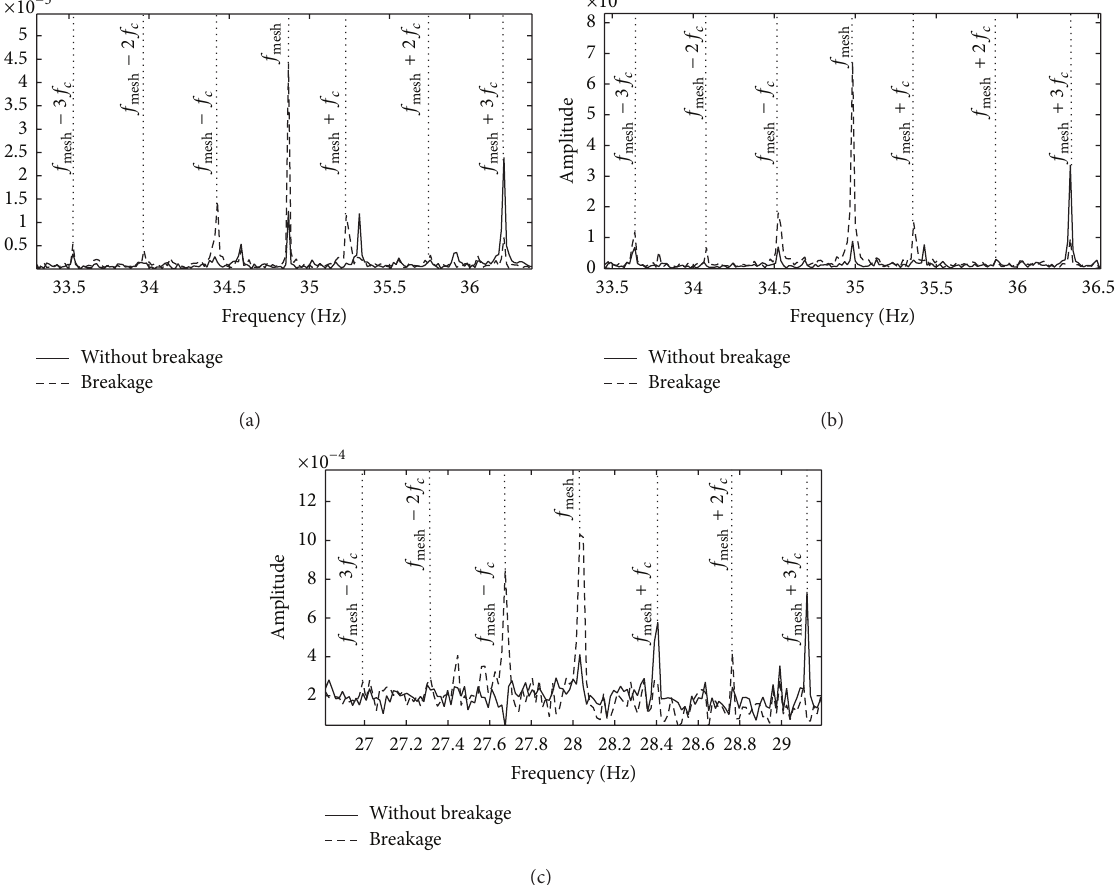
(without breakage) and the two fault modes. The sampling frequency is 16384 Hz.